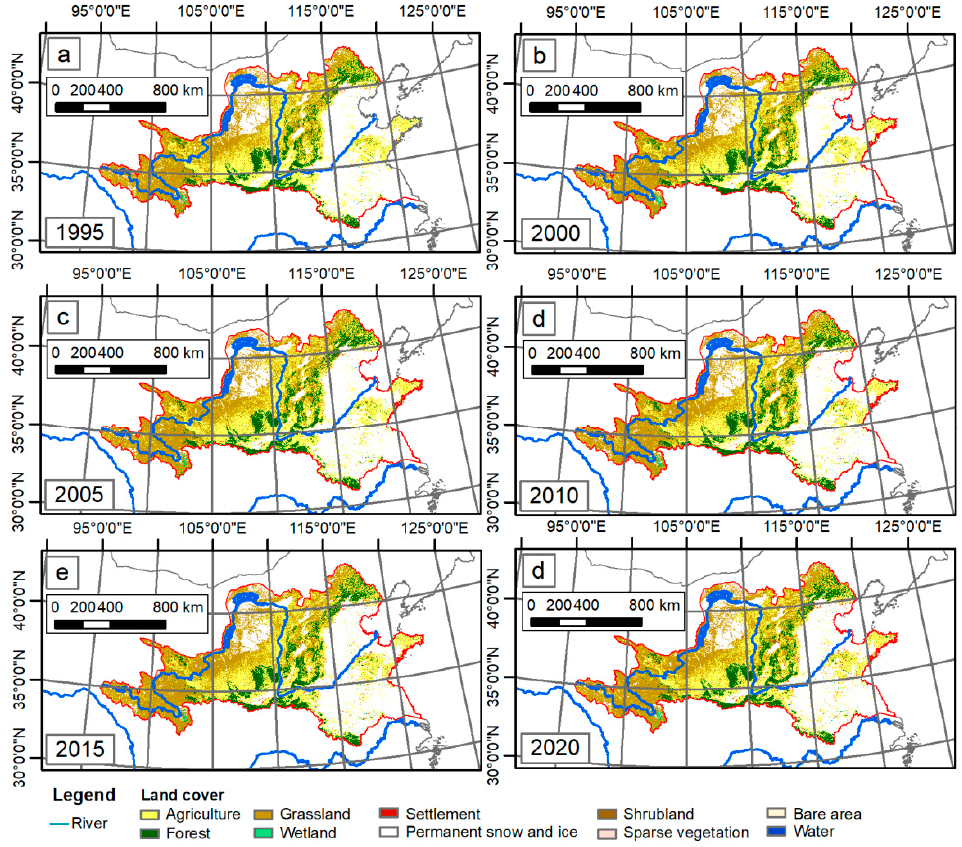
Figure 11. Land cover in mountainous areas of the GYRR in different years.